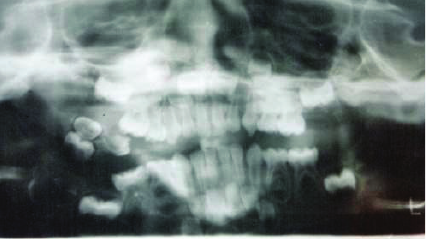
Figure 3: Orthopantomograph showing location of mass in the right buccal mucosa.